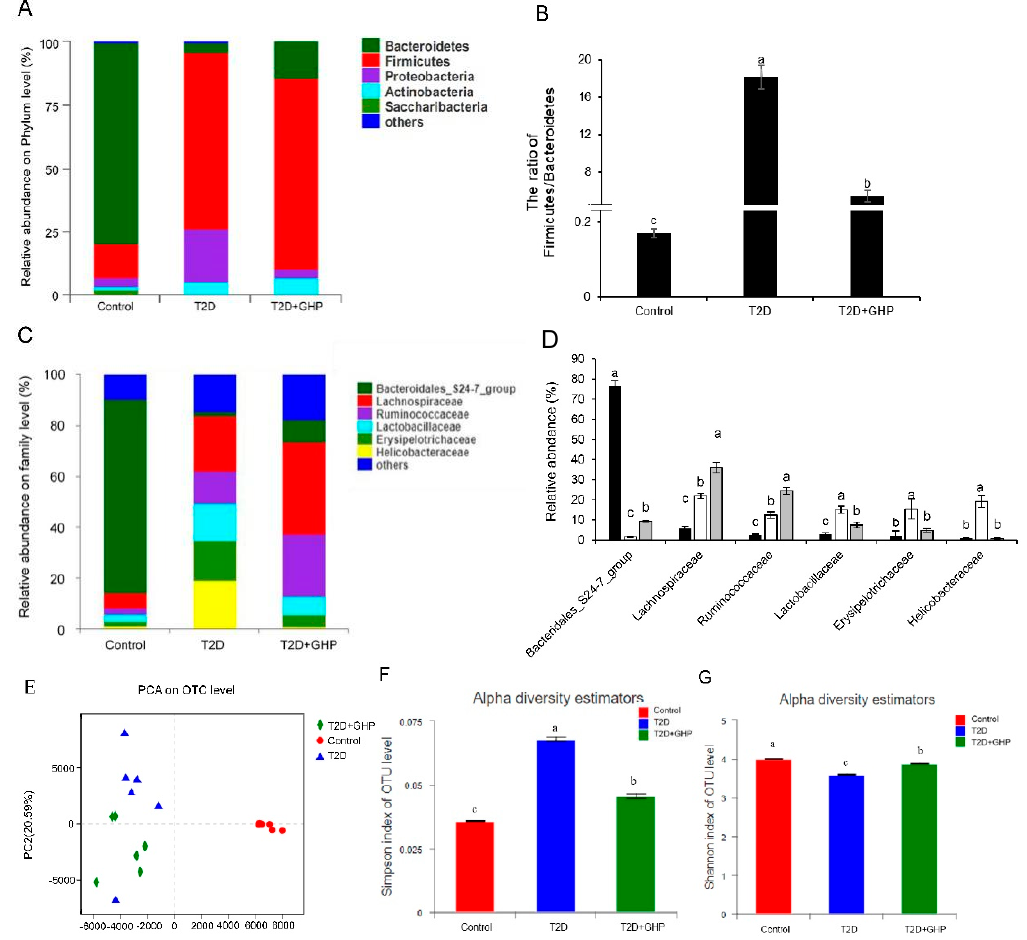
Figure 6. GHP supplementation regulated the composition and diversity of the gut microbiota in T2D mice. ( A ) Relative abundance of gut microbiota at the phylum level. ( B ) The ratio of Firmiutes / Bacteroidetes . ( C , D ) Relative abundance of gut microbiota at family level. ( E ) PCA plots at OTU level. ( F ) Simpson index and ( G ) Shannon index at OTU level.